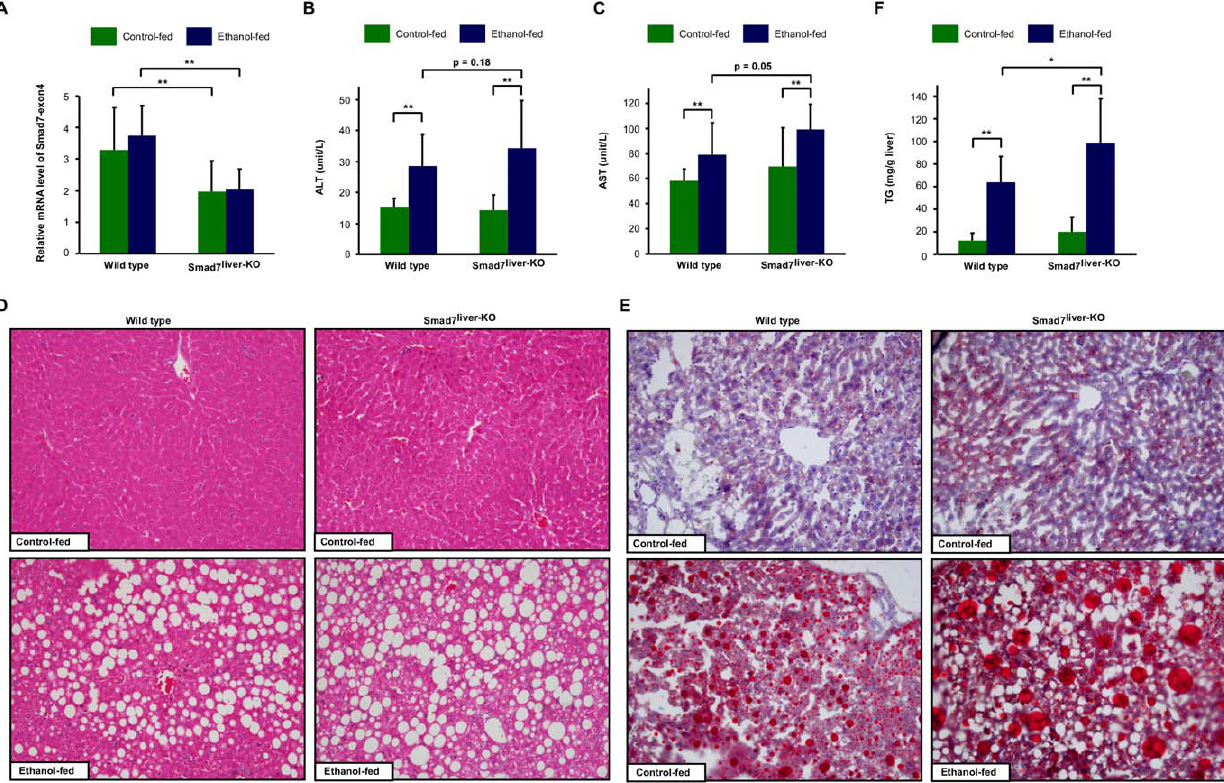
Figure 5. Alcohol-induced liver injury and steatosis were aggravated in Smad7 liver-KO mice. (A) Confirmation of Smad7 deletion. Wild type and Smad7 liver-KO mice were fed with control or ethanol-containing diet for 6 weeks, followed by a single gavage of 10% ethanol or maltose respectively (8 mice per group). Real time RT-PCR was performed with total RNA isolated from the mice with primers to detect the mRNA region corresponding to exon4 of Smad7 gene. (B) and (C) Measurement of serum ALT and AST. The data are shown as mean 6 SD and ** indicates p , 0.01 by Student’s t-test. (D) Histological analysis of the liver. Representative images of H&E staining are shown for each group of mice. Please note that fatty liver degeneration induced by alcohol administration is enhanced in Smad7 liver-KO mice. (E) Oil-Red-O staining of the liver. (F) Triglyceride level of the liver. The data are shown as mean 6 SD. * and ** indicates p , 0.05 and p , 0.01 respectively.